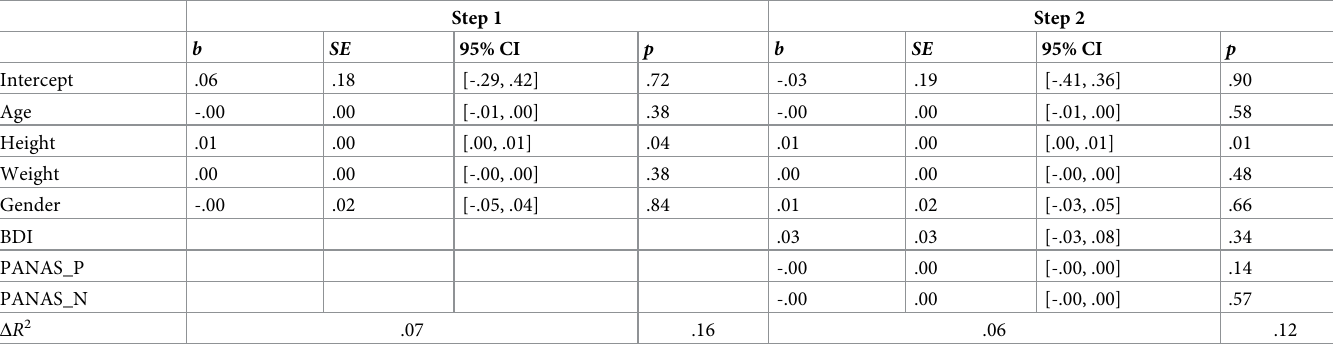
Table 4. Regression results for stride